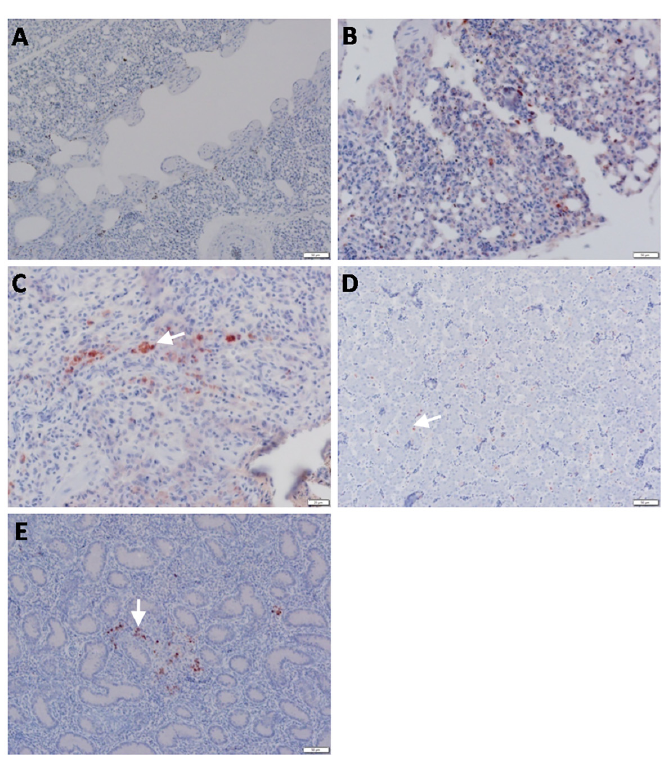
Fig 7. Detection of viral NP antigen in lung, liver and testisby IHC. ( A ) Lung of non-infected birds (X = 50 μ m). ( B and C ) Macrophages and mononuclear cells in lungs of infected birds (arrow) (X = 50 and 20 μ m, respectively). ( D ) Liver sinusoids of infected birds (inside van Kuppfer cells) (arrow) (X = 50 μ m). ( E ) Testis of infected birds (between seminephrous tubules of testicular tissue) (arrow) (X = 50 μ